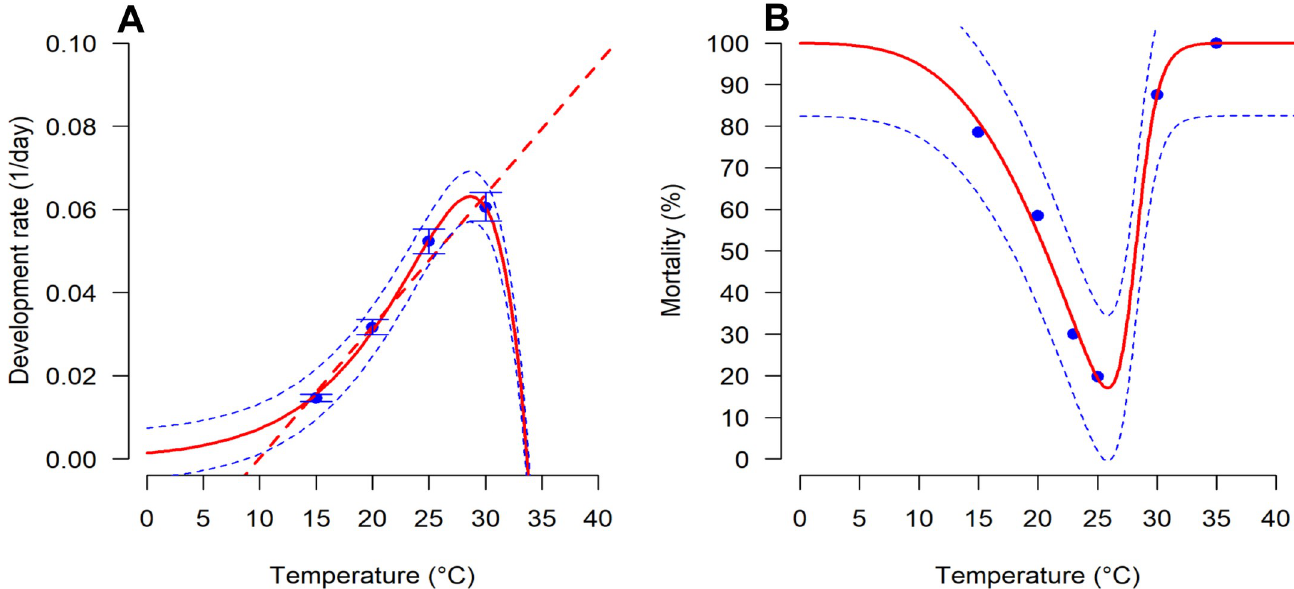
Fig 1. Model fitting to the relationship between (A) development rate from egg to adult and (B) mortality rate from egg to adult for Diachasmimorpha longicaudata reared at different constant temperatures. The blue points are the observed values of the experimental data; the dashed straight lines for linear models and solid lines for the Logan 1 and Wang 7 functions. Dashed lines in blue above and below represent the upper and lower 95% confidence interval. The experimental data for mortality was not well fitted by the model hence, we added a point at 23˚C to improve model fitting [34]. https://doi.org/10.1371/journal.pone.0255582.g001 However, in the first 7 days of oviposition, fecundity was highest at 30˚C followed by 25˚C (Fig 3). The Wang function 7 gave the best fit to the relationship between temperature and female fecundity (R 2 = 0.99 and AIC = 42.79) (Table 4; Fig 2B). The function predicted that females of D . longicaudata might be able to lay eggs under a temperature range between 10 and 36˚C, with a maximum fecundity at around 28˚C (Fig 2B). The adult senescence of both males and females was significantly influenced by temperature ( P < 0.05). The effect of temperature on D . longicaudata female and male senescence was predicted by Ratkowsky function (R 2 = 0.95 and AIC = -11.38) (Table 4; Fig 2C). The same function gave the best fit for the relationship between temperature and males senescence (R 2 = 0.94 and AIC = -13.44) (Table 4; Fig 2D). The senescence rate for both males and females was low at 15˚C and increased gradually with an increase in temperature (Fig 2C and 2D).